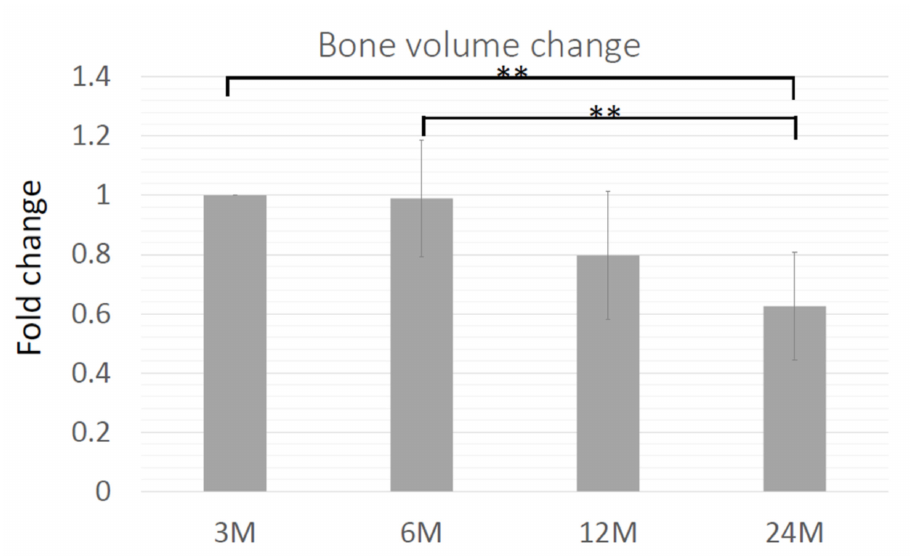
Figure 7. Time course of bone volume. The relative volume of the regenerating bone was shown as the percentage of volume at 3 months. ** p < 0.01.